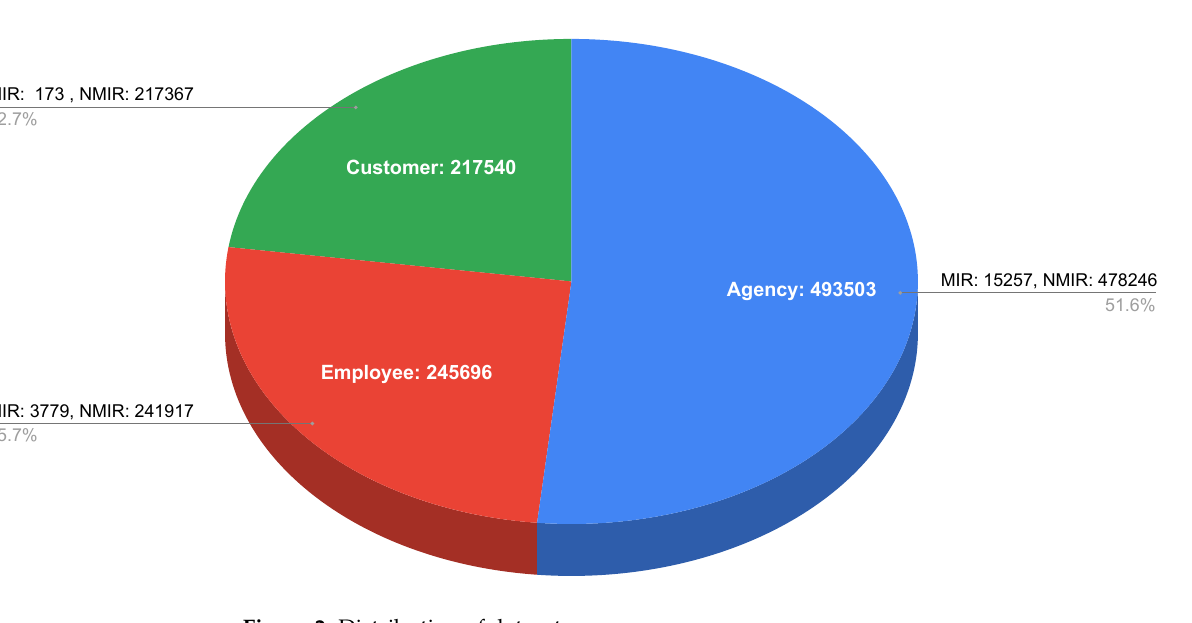
Figure 2. Distribution of